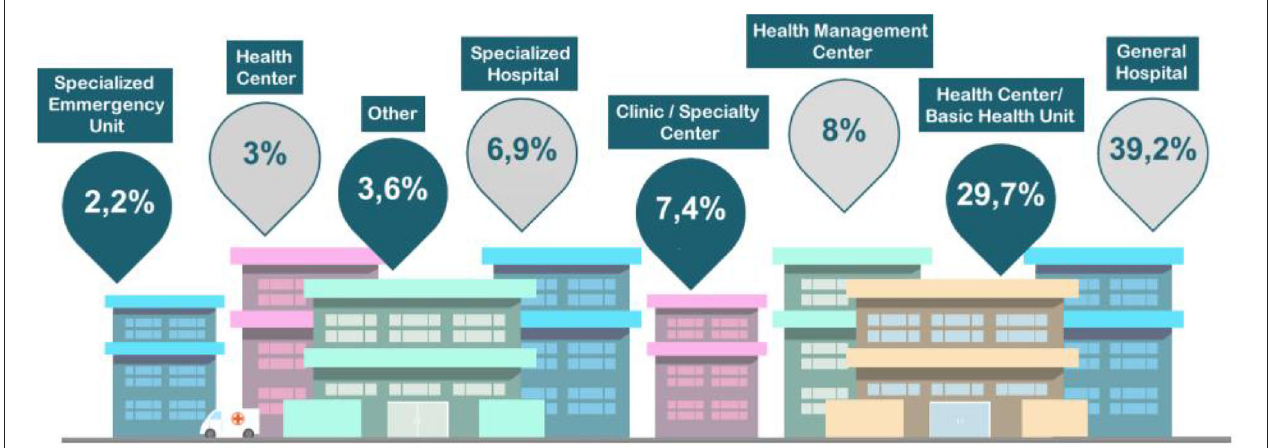
FIGURE 6 | Percentage of professional establishment of participants.